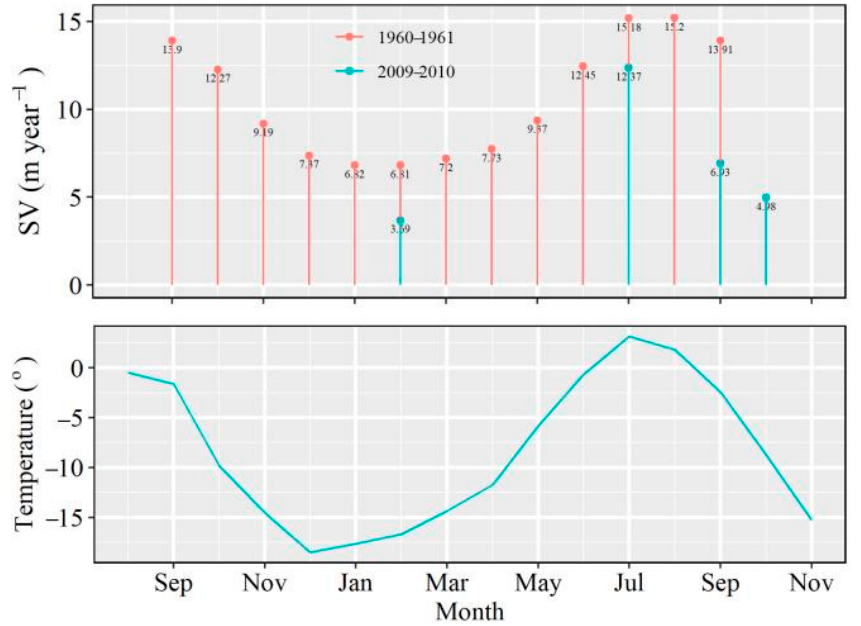
Figure 8. Relationship between surface velocity (SV) and monthly air temperature at the confluence region (4550 m a.s.l.; the data source for the period of September 1960–September1961 was the literature [50]).